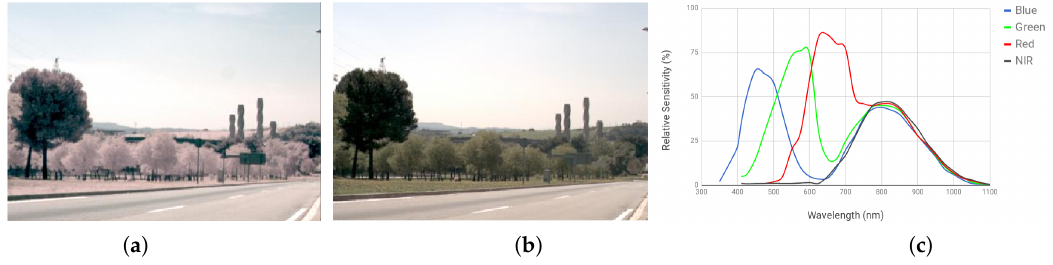
Figure 1. ( a ) RGB+N image (infected with near infrared, NIR); ( b ) RGB image obtained with an infrared cutoff filter (free of NIR infection); ( c ) multi-spectral sensitivity graph for a single sensor camera without an infrared cutoff